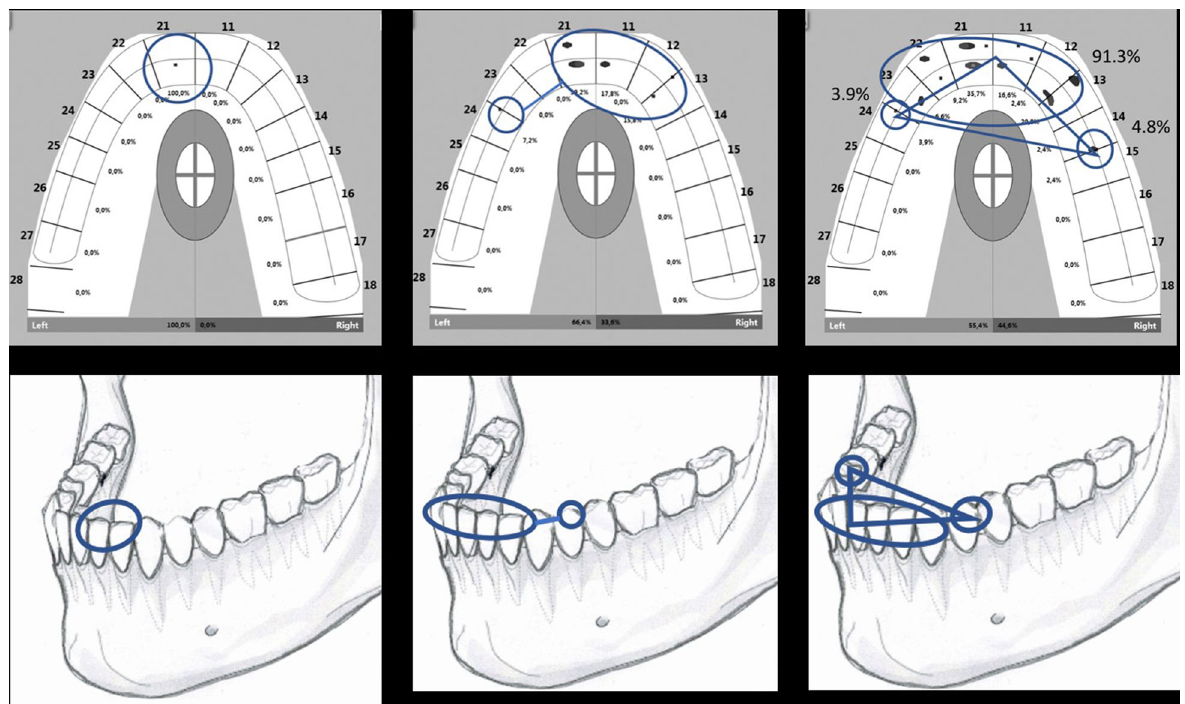
Fig. 2 The kinematics of a typical AF-bite. Succession of screenshots of a T-Scan movie demonstrate the development of occlusal contacts of the upper dental arch from timepoint tZ until tS. For each tooth the percentage of the bite force of that timepoint is indicated. The left panel depicts the timepoint tZ, the starting point (0 ms) of accumulation of occlusion contacts. The total bite force is 0.2% mFpr, of which 100% is subjected to the left central incisor. The ANT/BAT ratio of force distribution is 100/0. The middle panel is a snapshot taken 53 ms later, at the timepoint tW. The total bite force is 2.0 % of the mFpr. All the ANT-contacts together bear 92.8% of the mFpr, whereas the rest, 7.2% of the bite force is subjected to the BAT, the left fi rst premolar. The left BAT and the multiple contacts of the ANT area (encircled) form an ANT-BAT- axis allowing for a contralateral tilt of mandible only. The right panel, at timepoint 102 ms after the fi rst contact of the occlusion process, depicts the “ triangle of support ” -concept. The occlusal contact forces are distributed to the left BAT, ANT and the right BAT compartments of the dental arch. The bite force is 6.1 % mFpr. The ANT/BAT ratio is 91.3/8.7.